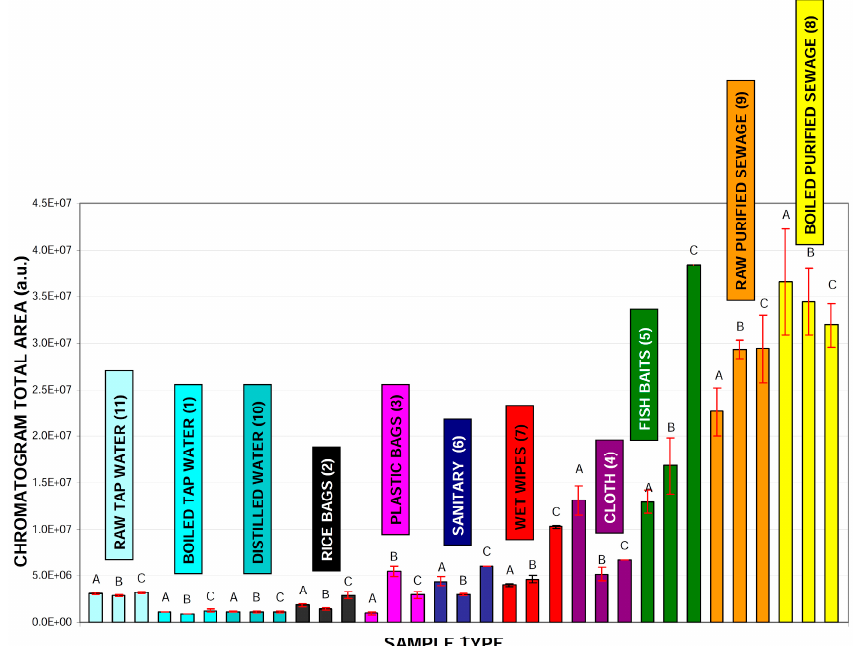
Figure 5. Integrated areas of all individual samples (labelled as A, B and C) related to extracted materials presented as average bars in Figure 6.